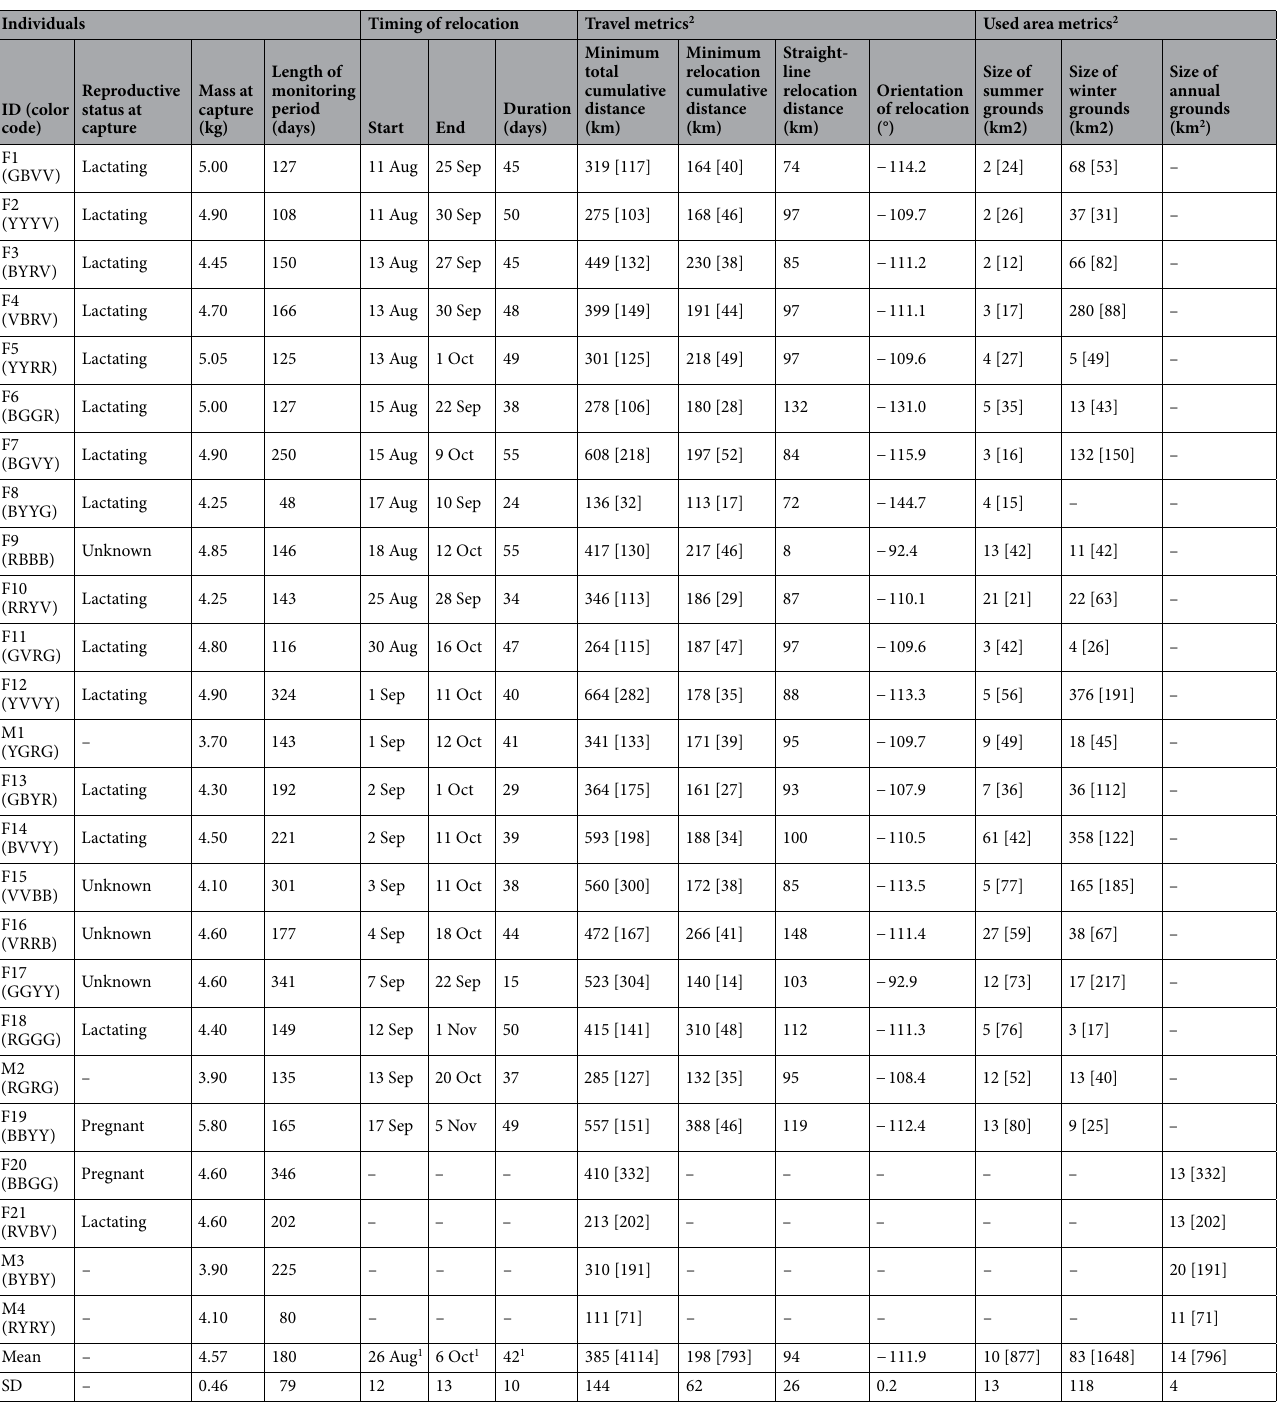
Table 1. Metrics describing individual Arctic hares and their movement ecology in a population studied at Alert (Nunavut, Canada). Timing of relocation and metrics describing travels and used areas are indicated for 25 hares tracked from 15 June 2019 to 31 May 2020. ID combines the sex of the individual (F, female; M, male), followed by a unique number. Ear-tag colors of individuals are also given in parentheses. 1 Applies only to relocated individuals. 2 Values in square brackets give sample size (number of